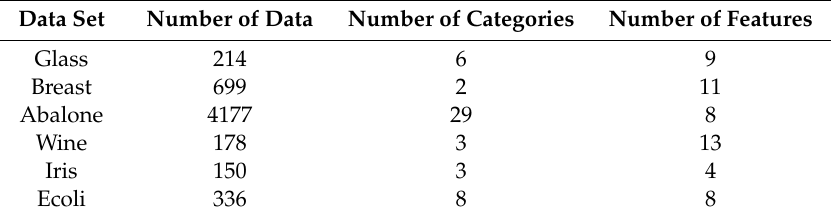
Table 9. UCI data sets for validation.